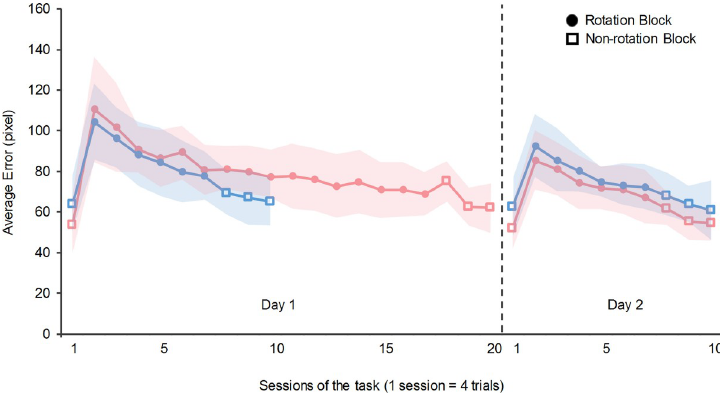
Fig 4. Task performance of Group 3 and Group 4 (48-h-interval groups). The horizontal axis represents the number of sessions of the tracking task, and the vertical axis represents the average error. The dashed line separates the results of Day 1 and Day 2. The blue line represents Group 3 (participants who performed 10 sessions on Day 1). The pink line represents Group 4 (participants who performed 20 sessions on Day 1). The open squares represent non-rotation sessions, and the filled circles represent rotation sessions. The background shadow shows the standard deviation of each group. As with the 24-h-interval groups, the error increased in the second session on Day 1 in both the groups, after which it